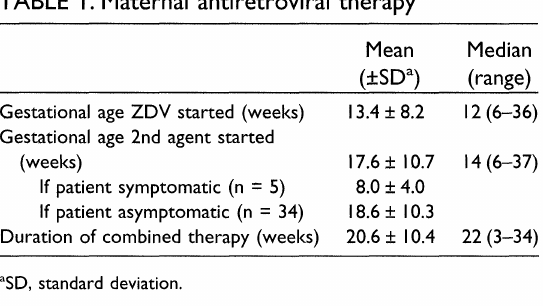
TABLE I. Maternal antiretroviral